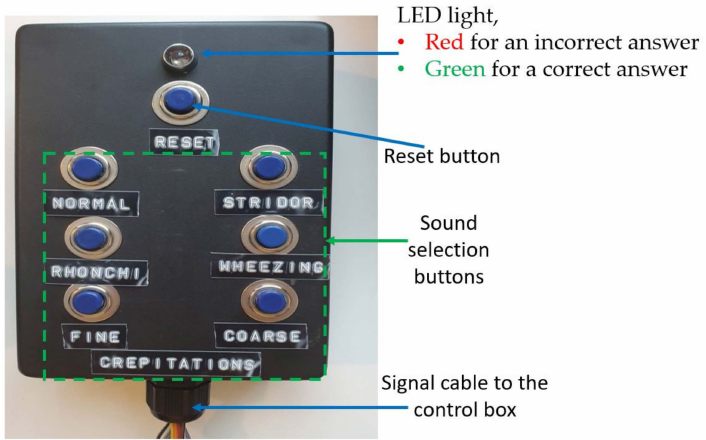
Figure 7. A response box.